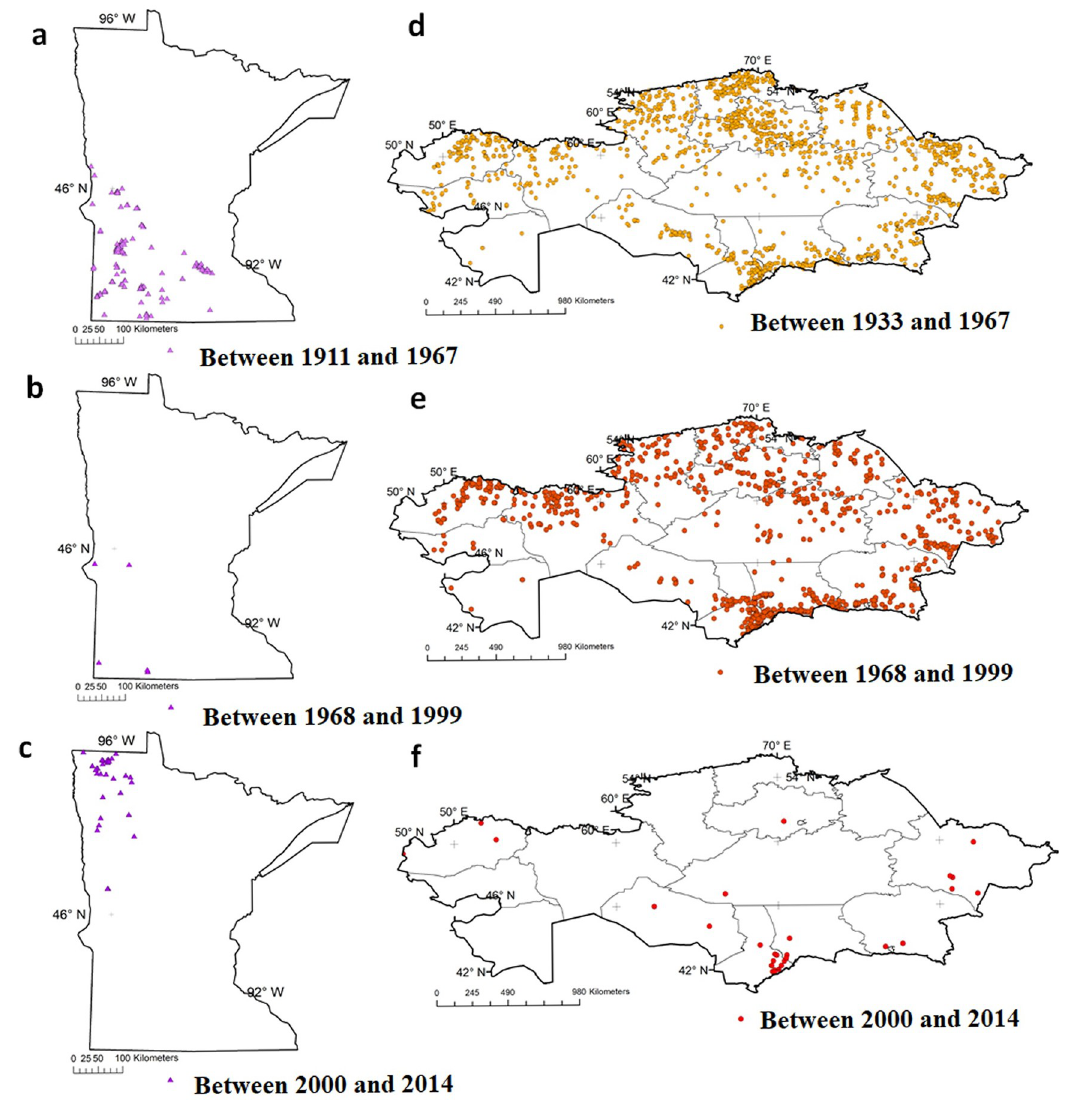
Fig 3. Maps illustrating the distribution of animal Anthrax at certain time intervals. Panels a, b, and c represents cases in Minnesota between 1912 and 2014. Panels d, e, and, f represents cases in Kazakhstan between 1933 and 2014.